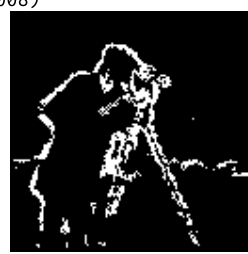
Figure 10. Edge extracted using ACO proposed by (Tian et al.,